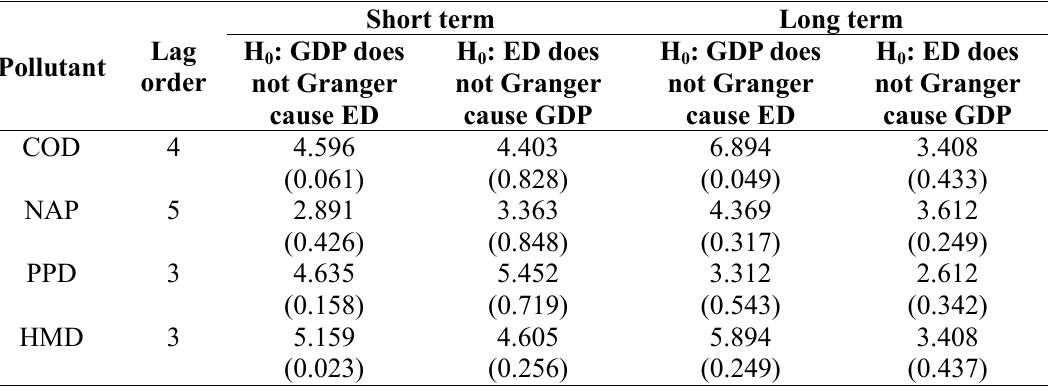
Table 4. Results of the Granger causality